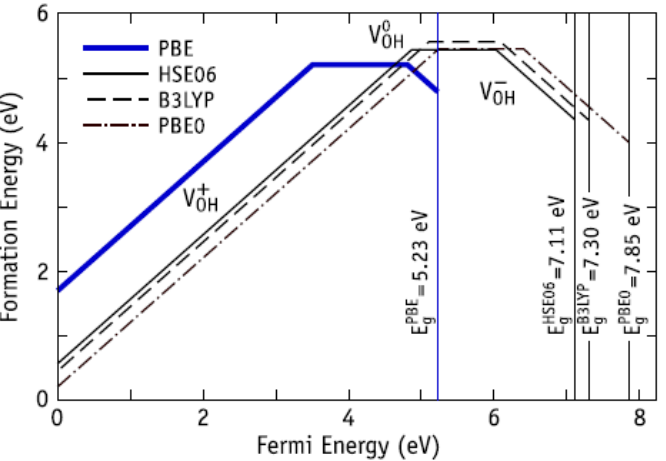
Figure 16. Calculated formation energy of V OH in HAp as a function of the Fermi energy. Positive, neutral, and negative charge states are represented by lines with positive, zero, and negative slope, respectively. The value of Fermi energy varies between the energy value of the top of valence band E V (E F = 0 eV) and the energy value of the bottom of conductive band E C ( E F = ~ E g). Reprinted with permission from [34]. CCC (2018) AIP Publishing.